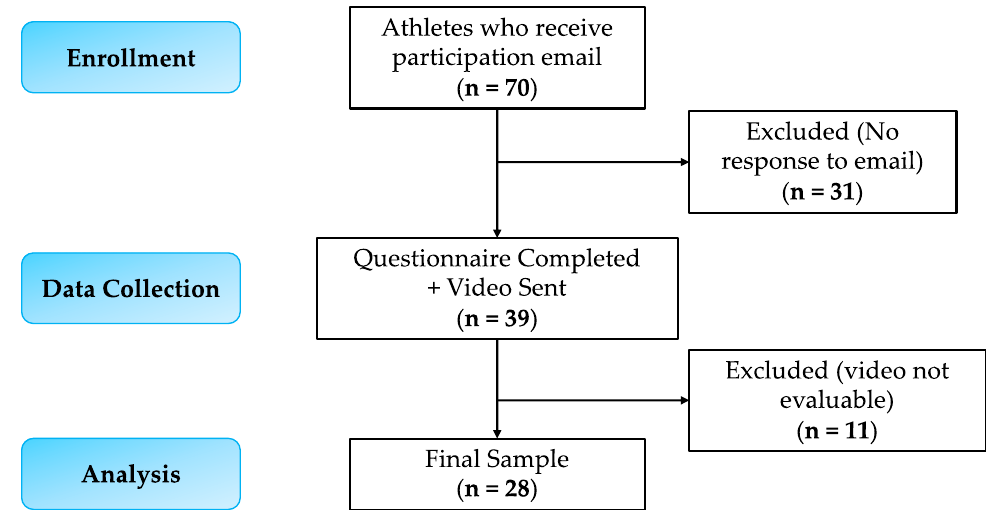
Figure 1. Flowchart diagram for study participants.